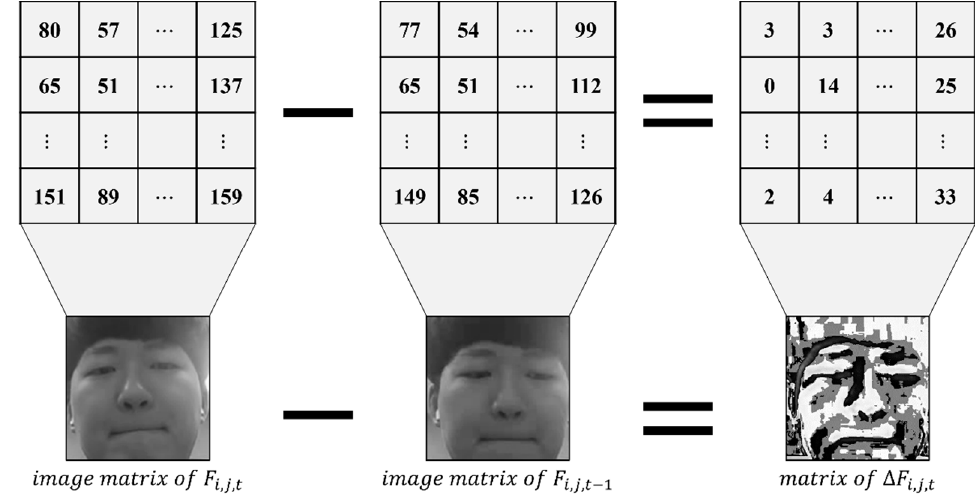
Figure 4. Change of image t and image t − 1.